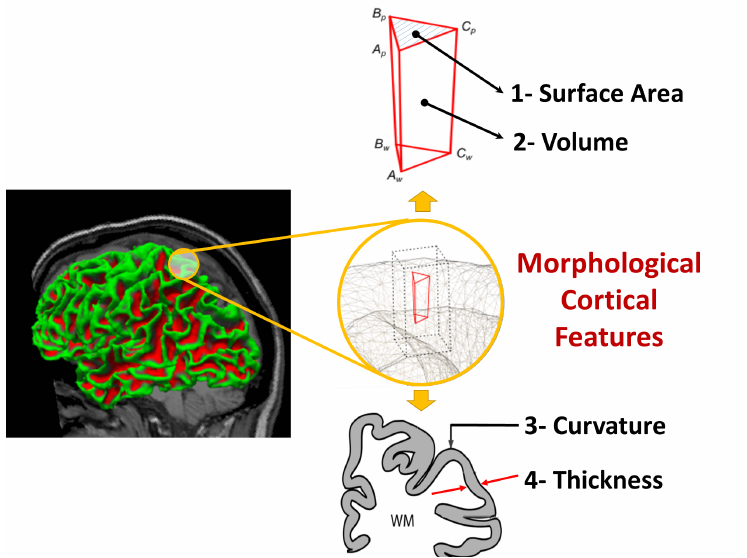
Figure 2. Morphological features extracted from brain surfaces by freesurfer.